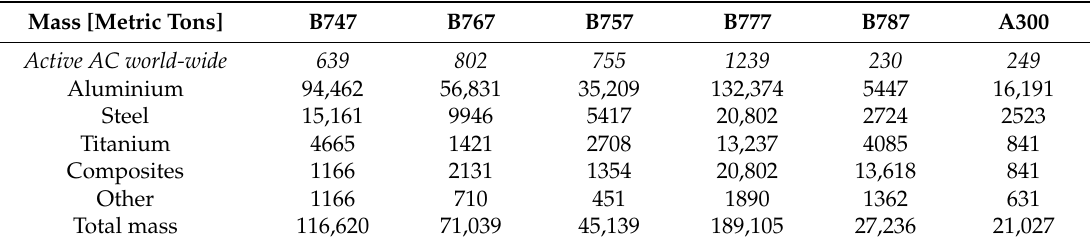
Table 4. The composition of selected active aircraft related to material categories.